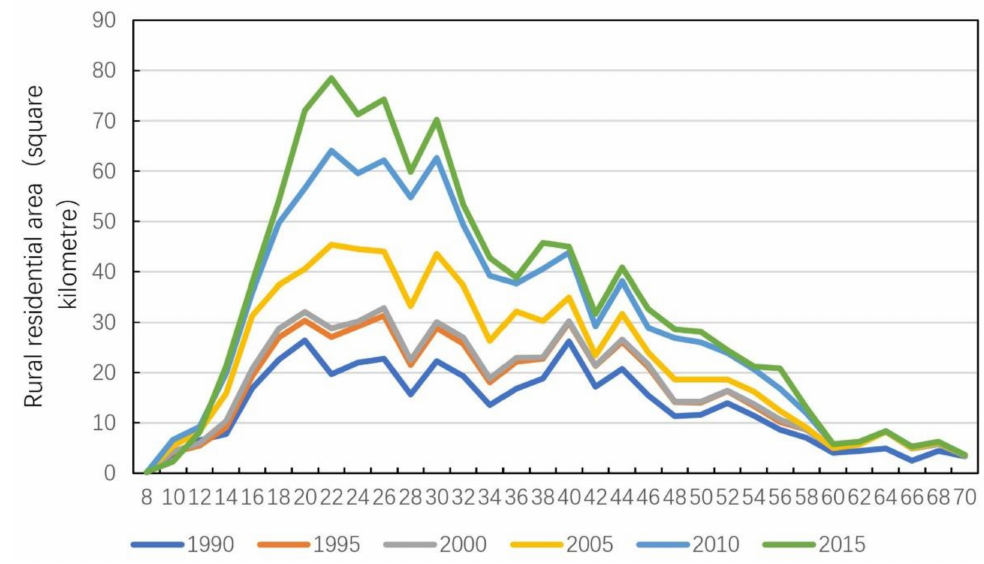
Figure 3. Statistical chart of the spatial variation in the distances between rural residential areas in the suburbs of